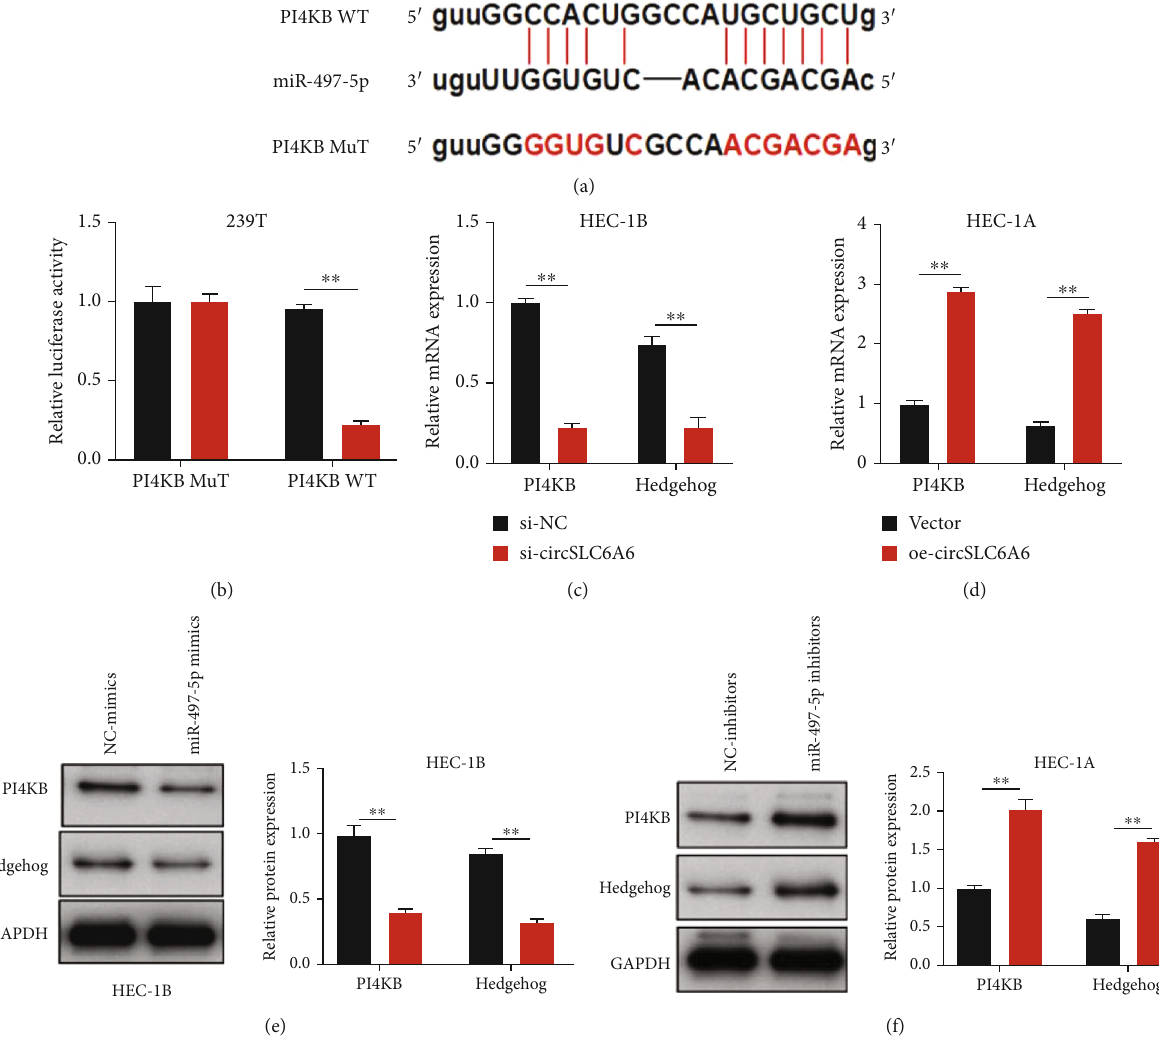
Figure 4: miR-497-5p mediates the PI4KB/hedgehog pathway in EC. (a) The putative binding sites between PI4KB WT/MuT and miR-497- 5p. (b) Luciferase report assay was performed to verify the interaction between PI4KB and miR-497-5p in 293T cells (black column — NC mimics, red column — miR-497-5p mimics). (c, d) The expressions of PI4KB and hedgehog in HEC-1B cells transfected with si- circSLC6A6 and HEC-1A cells transfected with oe-circSLC6A6 were detected by qRT-PCR. (e) The expressions of PI4KB and hedgehog in HEC-1B cells transfected with miR-497-5p mimics were detected by western blotting (black column — NC mimics, red column — miR-497- 5p mimics). (f) The expressions of PI4KB and hedgehog in HEC-1A cells transfected with miR-497-5p inhibitors were detected by western blotting (black column — NC mimics, red column — miR-497-5p inhibitors) ( ∗∗ p < 0 : 01